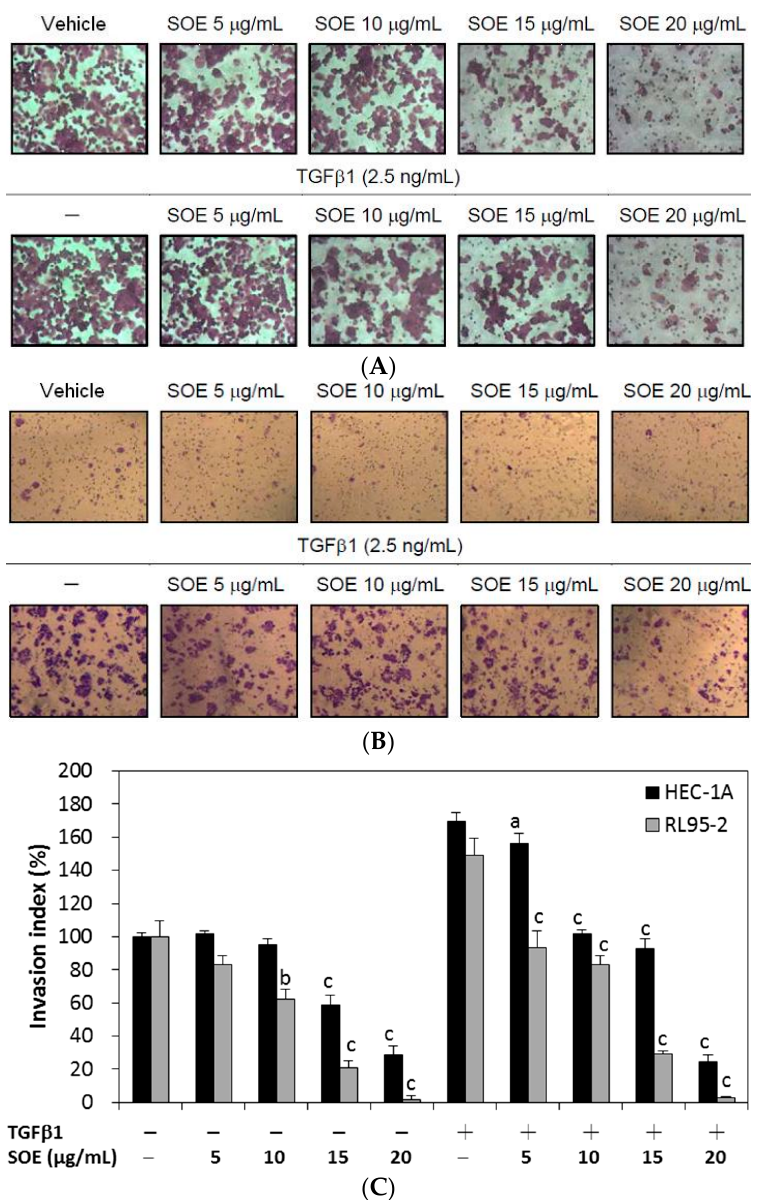
Figure 5. Effects of SOE dose on invasion of endometrial cancer cells. ( A ) HEC-1A cells; ( B ) RL95-2 cells; and ( C ) the invasion index of both cell lines. The invasion assay was conducted using the Boyden chamber. HEC-1A and RL95-2 cells were treated with various doses of SOE for 48 h. Cells that penetrated the Matrigel membrane to lower surface of the filter were stained with 0.5% crystal violet. The cell numbers were visualized under an inverted microscope with a magnification of 100× and were counted per field. The invasion index is defined as 100% without TGF β 1 induction and without SOE treatment. Three independent experiments were performed; results are expressed as mean ± SD. A significant difference from the respective vehicle, according to Student’s t -test, was indicated as “a” for p < 0.05; “b” for p < 0.01; and “c” for p < 0.001.